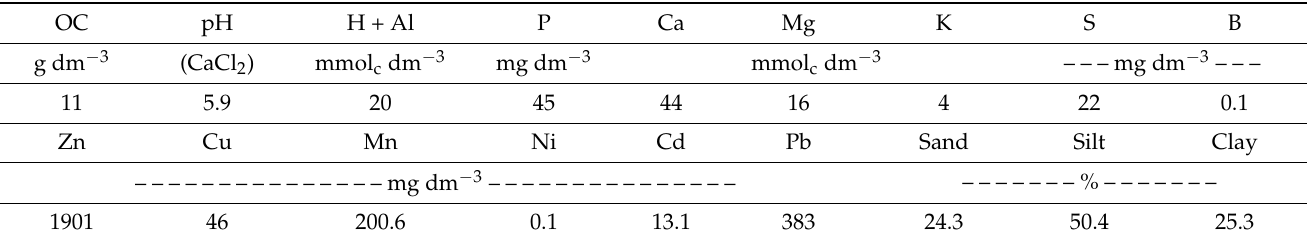
Table 2. Initial characterization of the multicontaminated